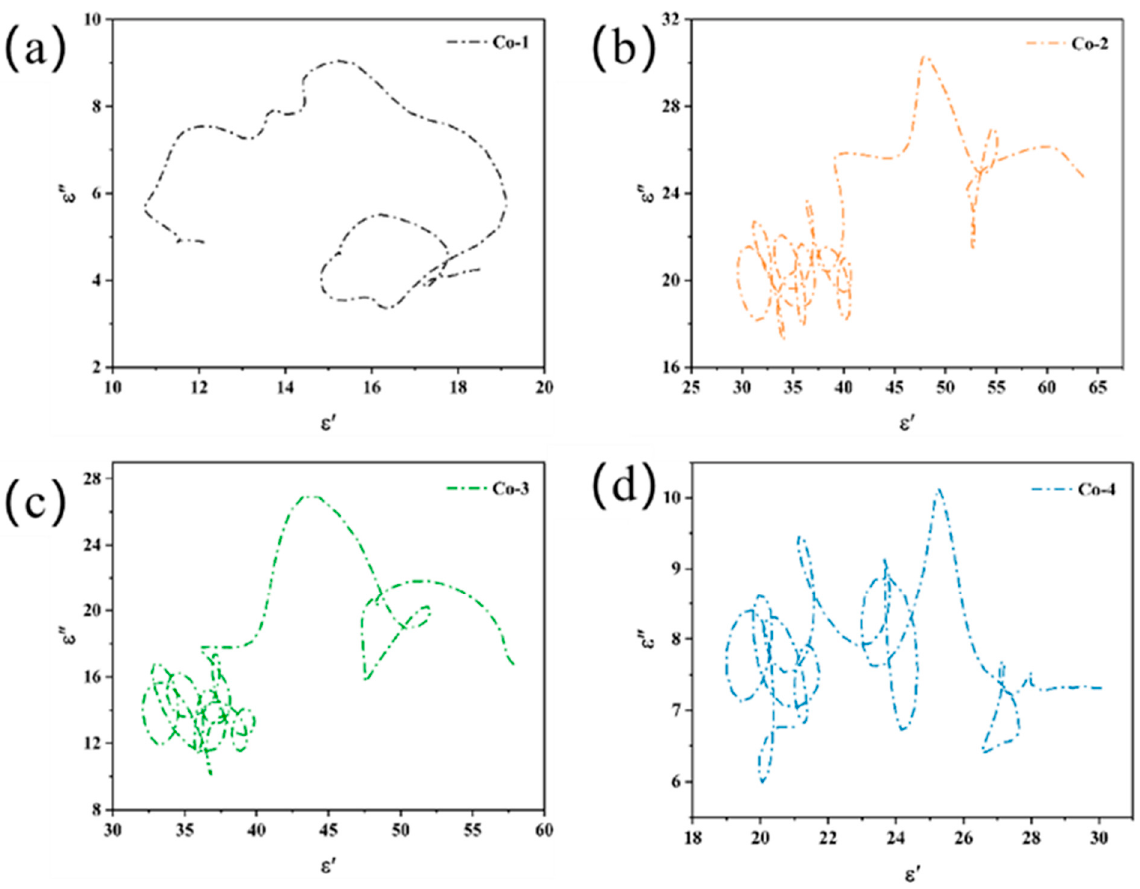
Figure 7. Cole-Cole curves of ( a ) Co-1, ( b ) Co-2, ( c )Co-3, ( d )Co-4.